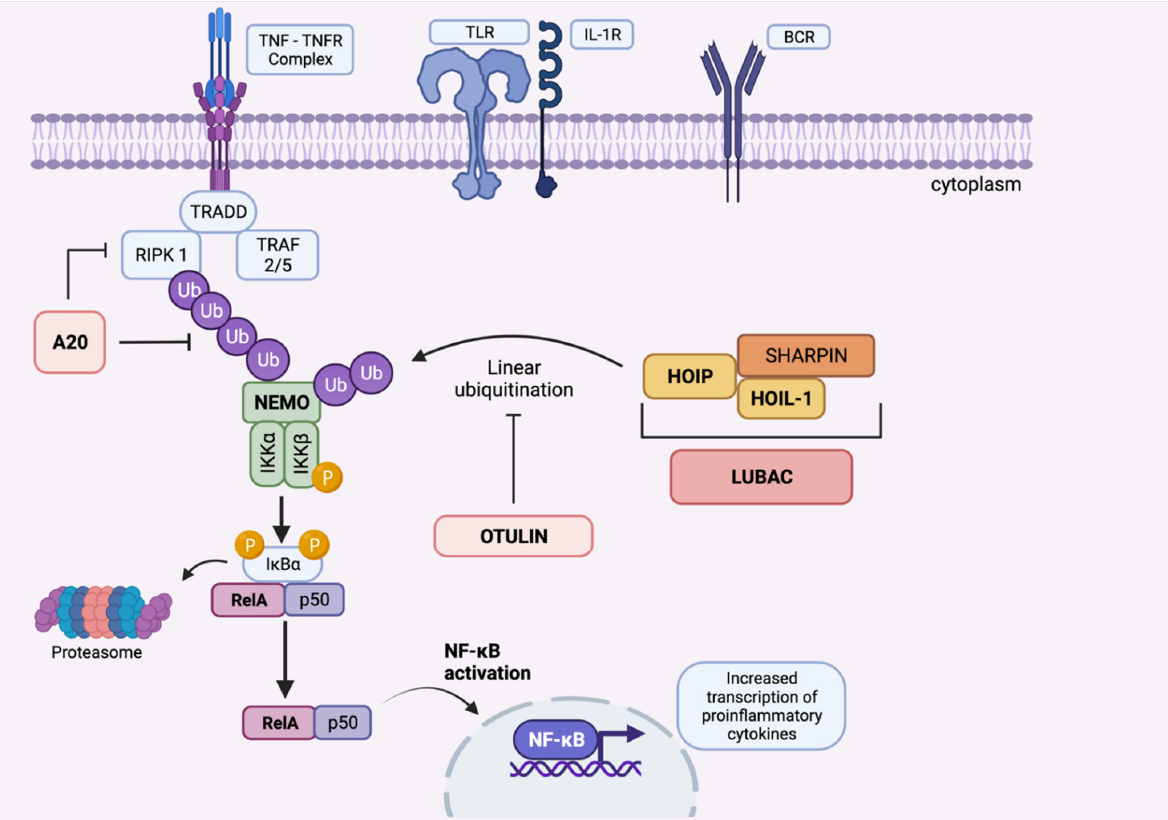
Figure 2. Overview of the canonical NF- κ B signalling pathway and the role of A20 and OTULIN proteins (created by Biorender). Mutations in proteins that can result in BD-like phenotypes are shown in bold. Induction of the pathway by Toll-like receptors (TLRs), T-cell receptors (TCRs), B-cell receptors (BCRs) and cytokine receptors (TNF α , IL-1 β , IL-6, etc.) initiates a cascade, followed by the stimulation of I κ B kinase (IKK) complex, which consists of three subunits: IKK α , IKK β , and IKK γ (NEMO, NF- κ B essential modulator). Activation of I κ B α via phosphorylation leads to release of